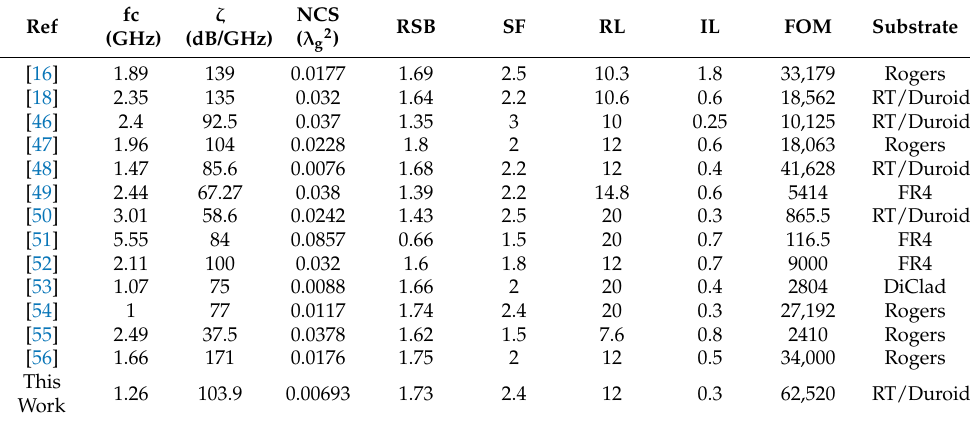
Table 2. Comparison between the proposed filter and some published